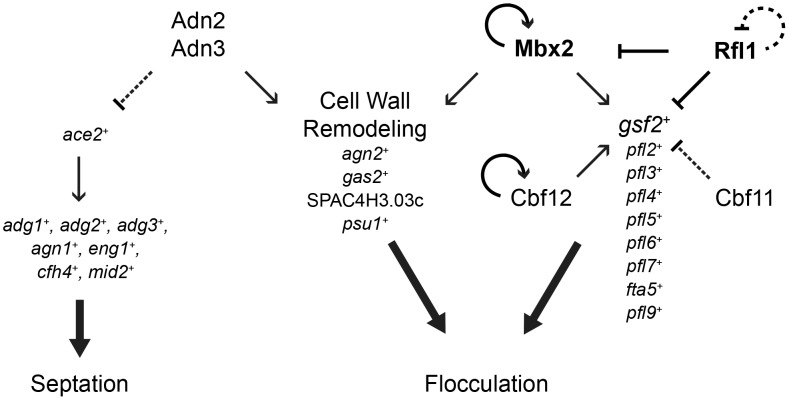
A model of the transcriptional-regulatory network of flocculation in S. pombe.Interactions of transcriptional activation and repression are indicated by arrows and bars, respectively. The major regulators of flocculation, Mbx2 and Rfl1 are in bold. Dash lines denote transcription factor-target gene interactions that may not be direct. See main text for a detailed description of the transcriptional-regulatory network.